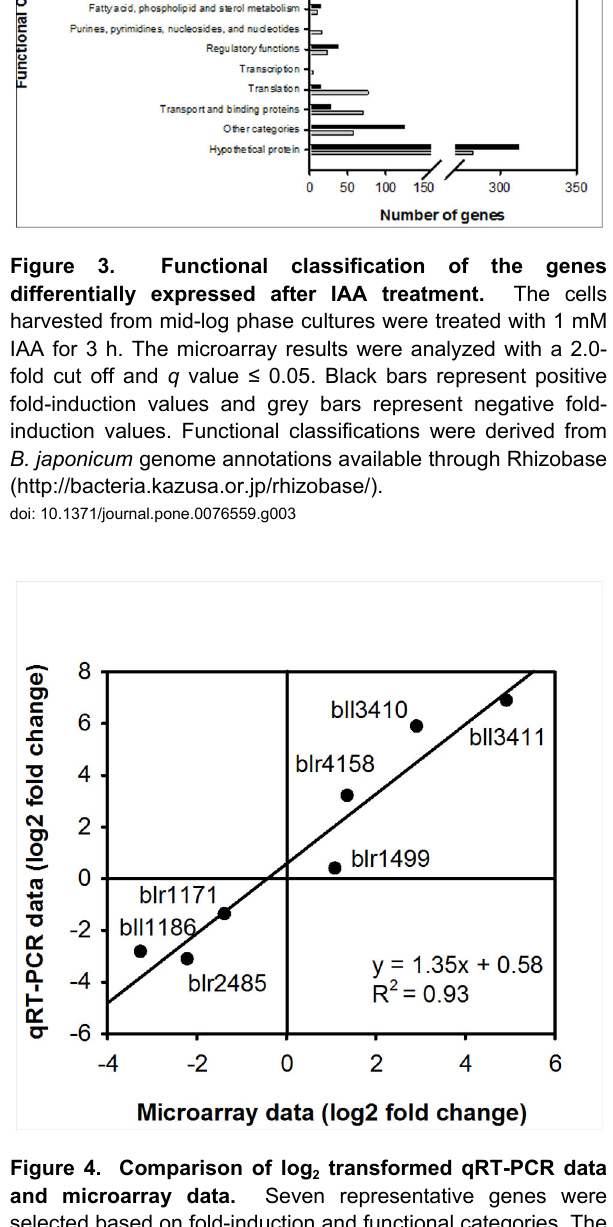
transformed qRT-PCR data 2